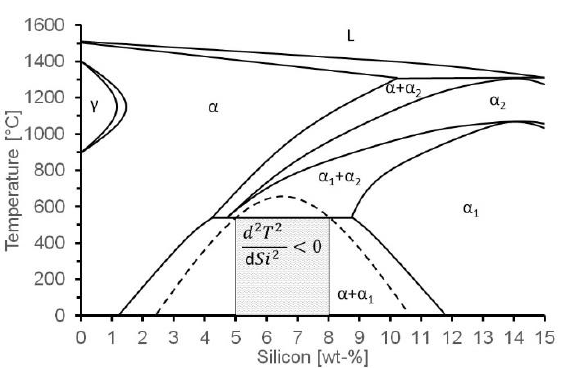
Figure 4. Phase diagrams for the Fe-Si-C system. Adapted from [43,44,54].